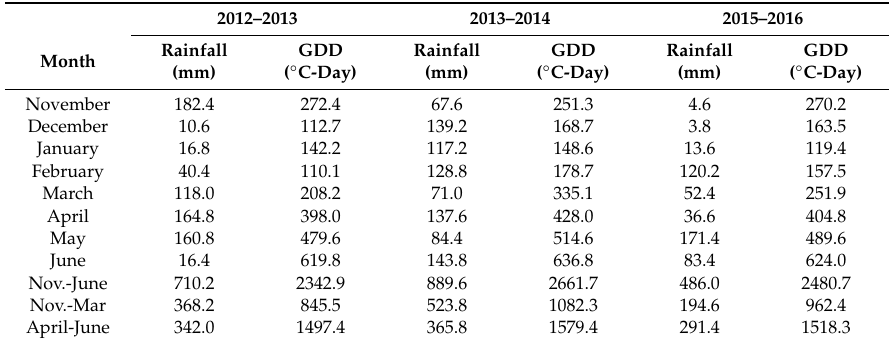
Table 2. Monthly rainfall and growing degree days (GDD) observed at Cigliano from sowing to the end of ripening in the period 2012–2016 ¥